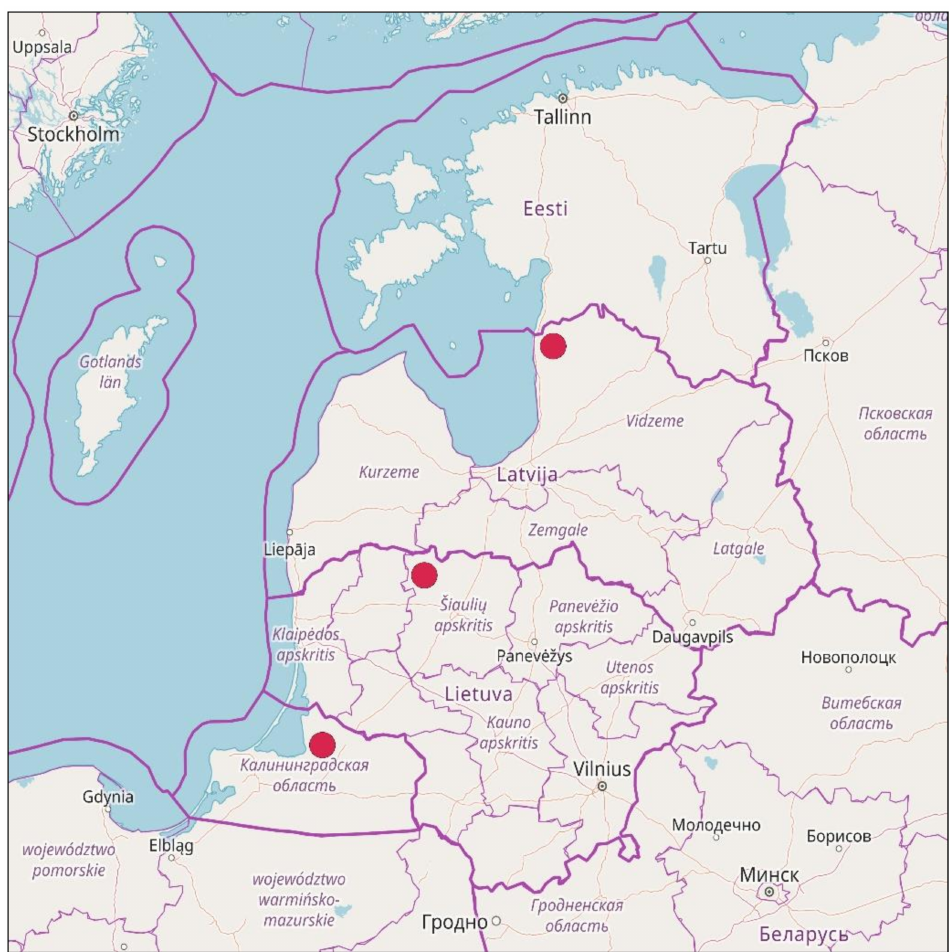
Figure 6. Distribution map of Splachnum pensylvanicum in the East Baltic